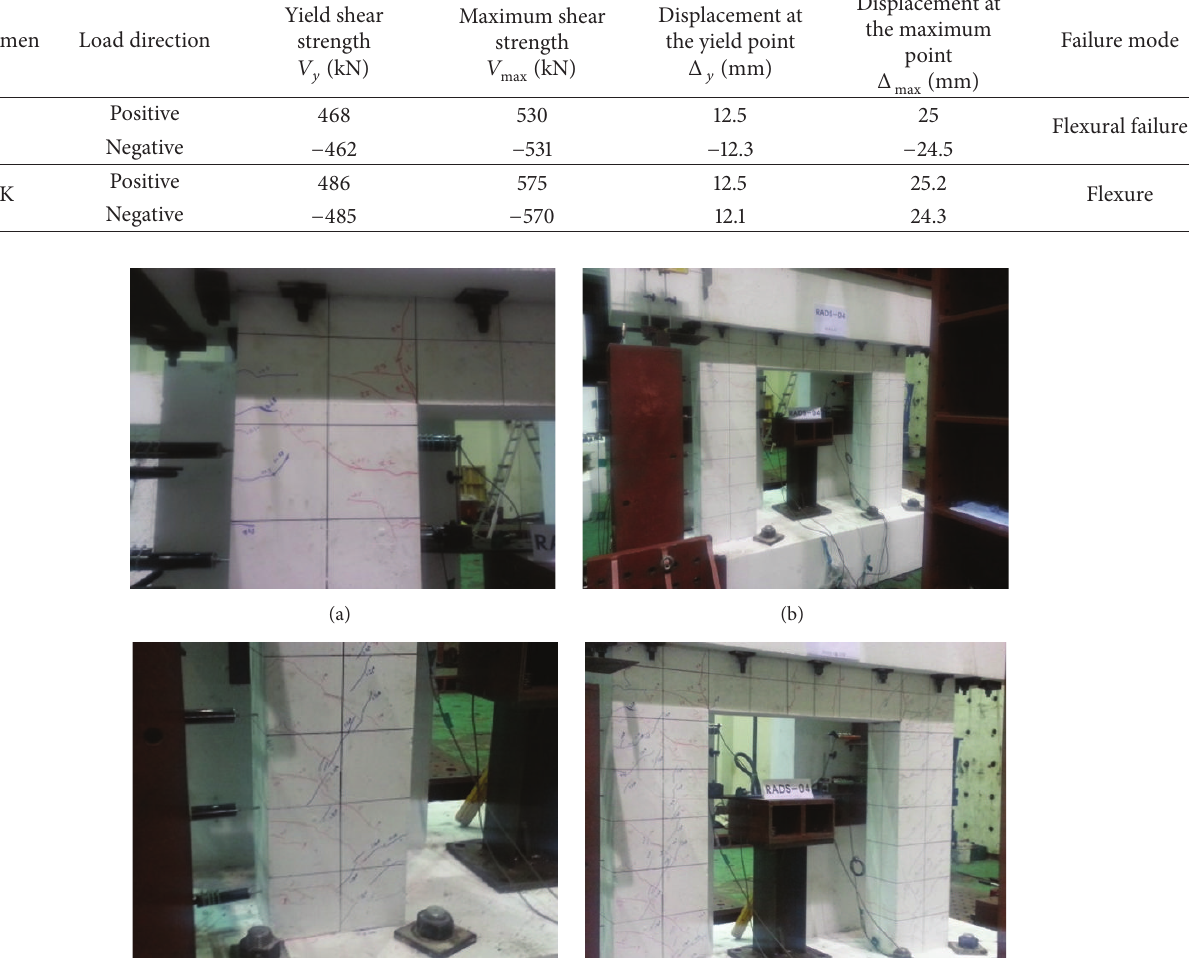
Figure 12: Cracks that appeared in the PD-FK specimen during pseudodynamic testing: (a) 2.7 s with lateral displacement of 7.5 mm in 200 gal, (b) the final stage (4s) in 200 gal, (c) 2.7 s with lateral displacement of − 25mm in 300 gal, and (d) the final stage (4s) in 300